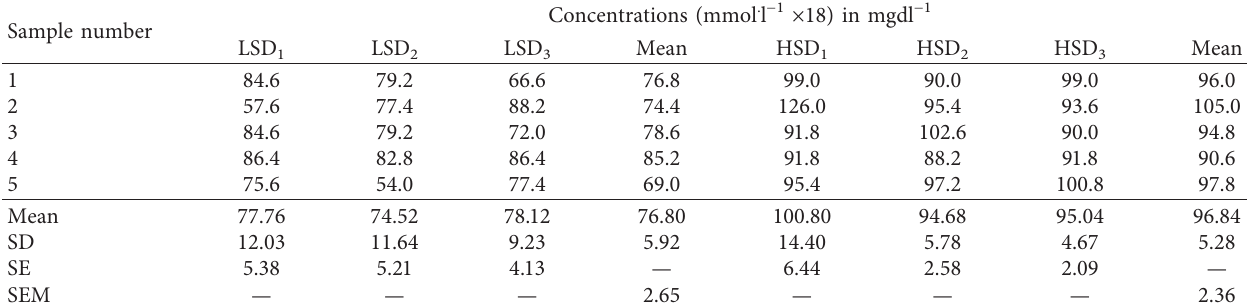
Table 4: Whole blood glucose concentrations and group means for LSD and HSD triplicates, at P < 0 . 05. Sample number